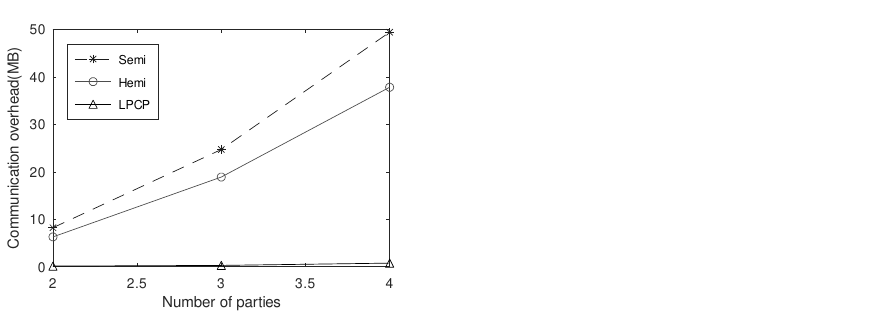
Figure 6. Total communication overhead of Semi, Hemi and LPCP in different party numbers